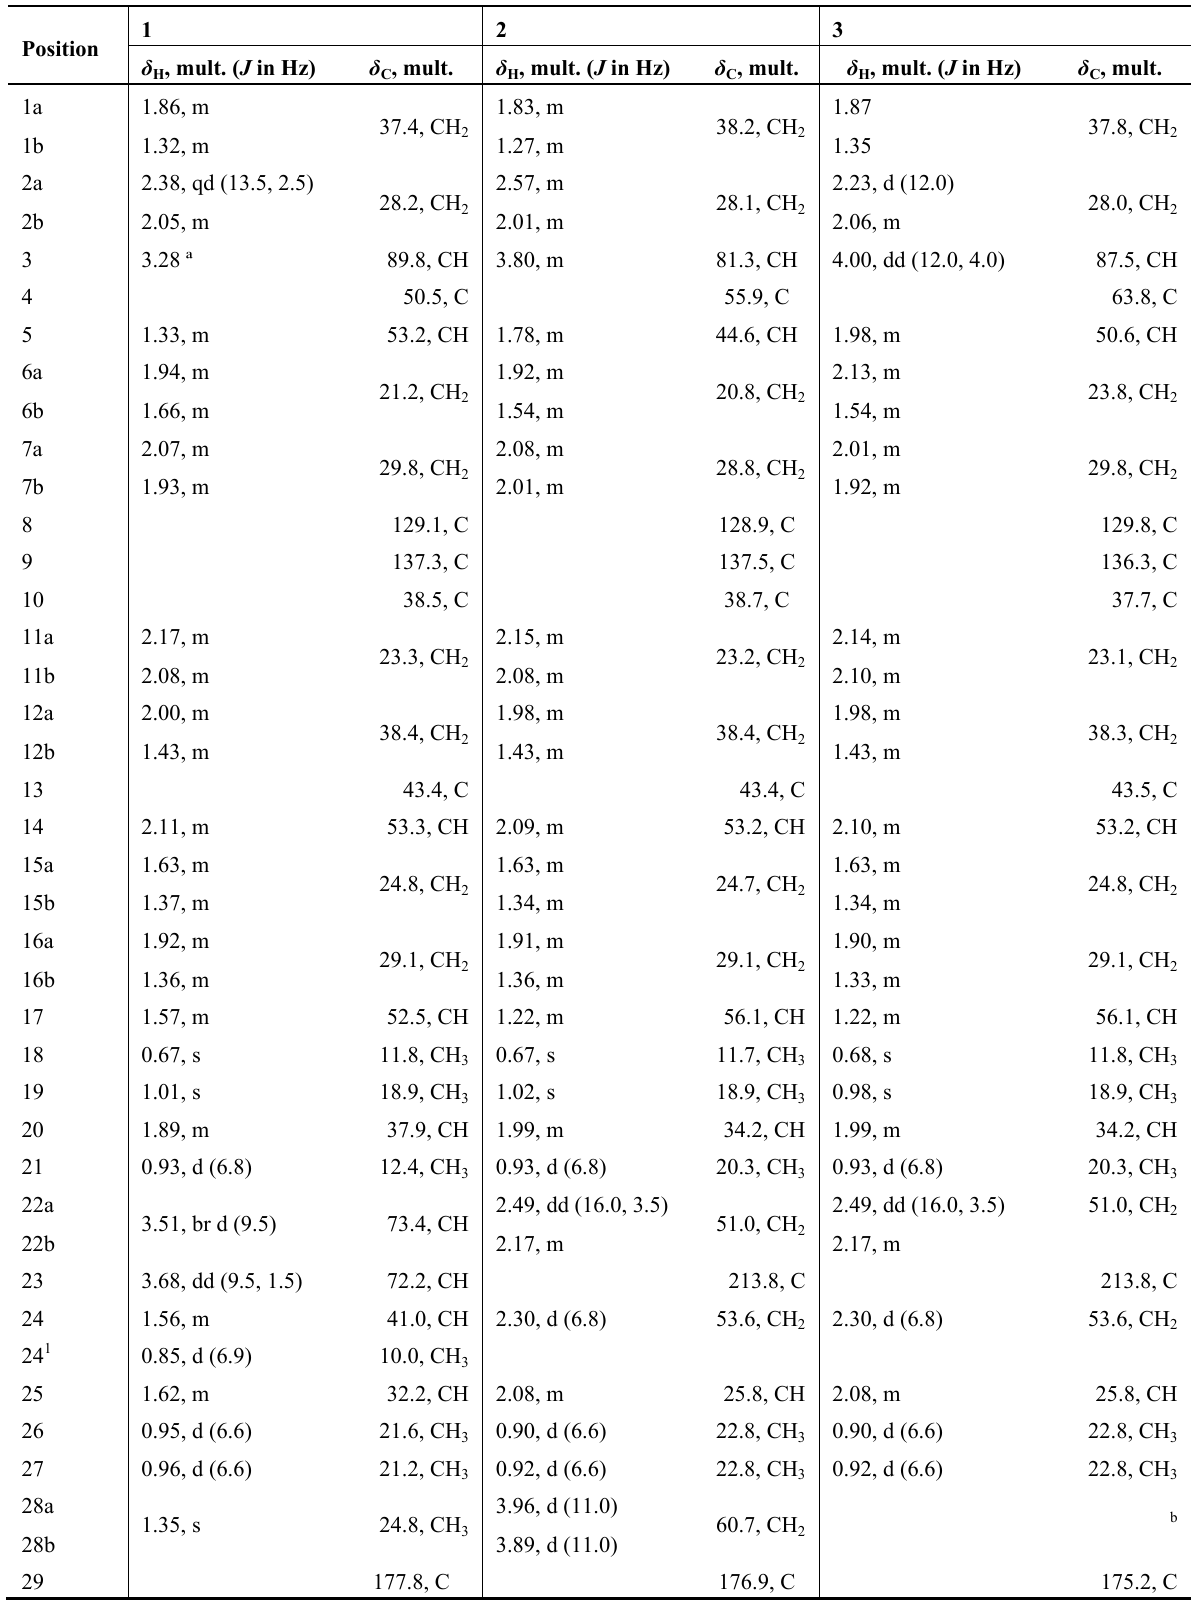
Table 1. 1 H (500 MHz) and 13 C-NMR (125 MHz) data for the aglycon of 1 , 2 , and 3 (in CD